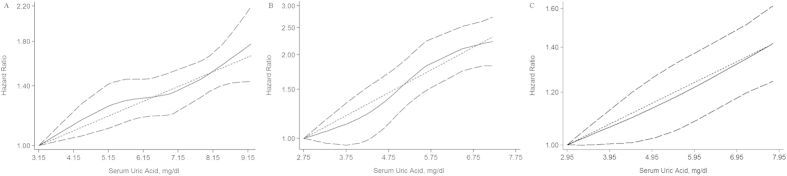
Dose-response relations between serum uric acid levels and risk of metabolic syndrome/non-alcoholic fatty liver disease in prospective studies.(A) Restricted cubic splines and generalized least squares dose-response models on evaluation of association between uric acid and risk of metabolic syndrome in men; (B) Restricted cubic splines and generalized least squares dose-response models on evaluation of association between uric acid and risk of metabolic syndrome in women; (C) Restricted cubic splines and generalized least squares dose-response models on evaluation of association between uric acid and risk of non-alcoholic fatty liver disease. The solid line represents the fitted hazard ratios curve compared to the subgroup with the lowest mean dose of uric acid, and flanked dotted line is 95%CI of this risk by restricted cubic splines model. Middle dotted line represents the weighted regression index compared to subgroup with lowest mean dose of uric acid by generalized least squares model.